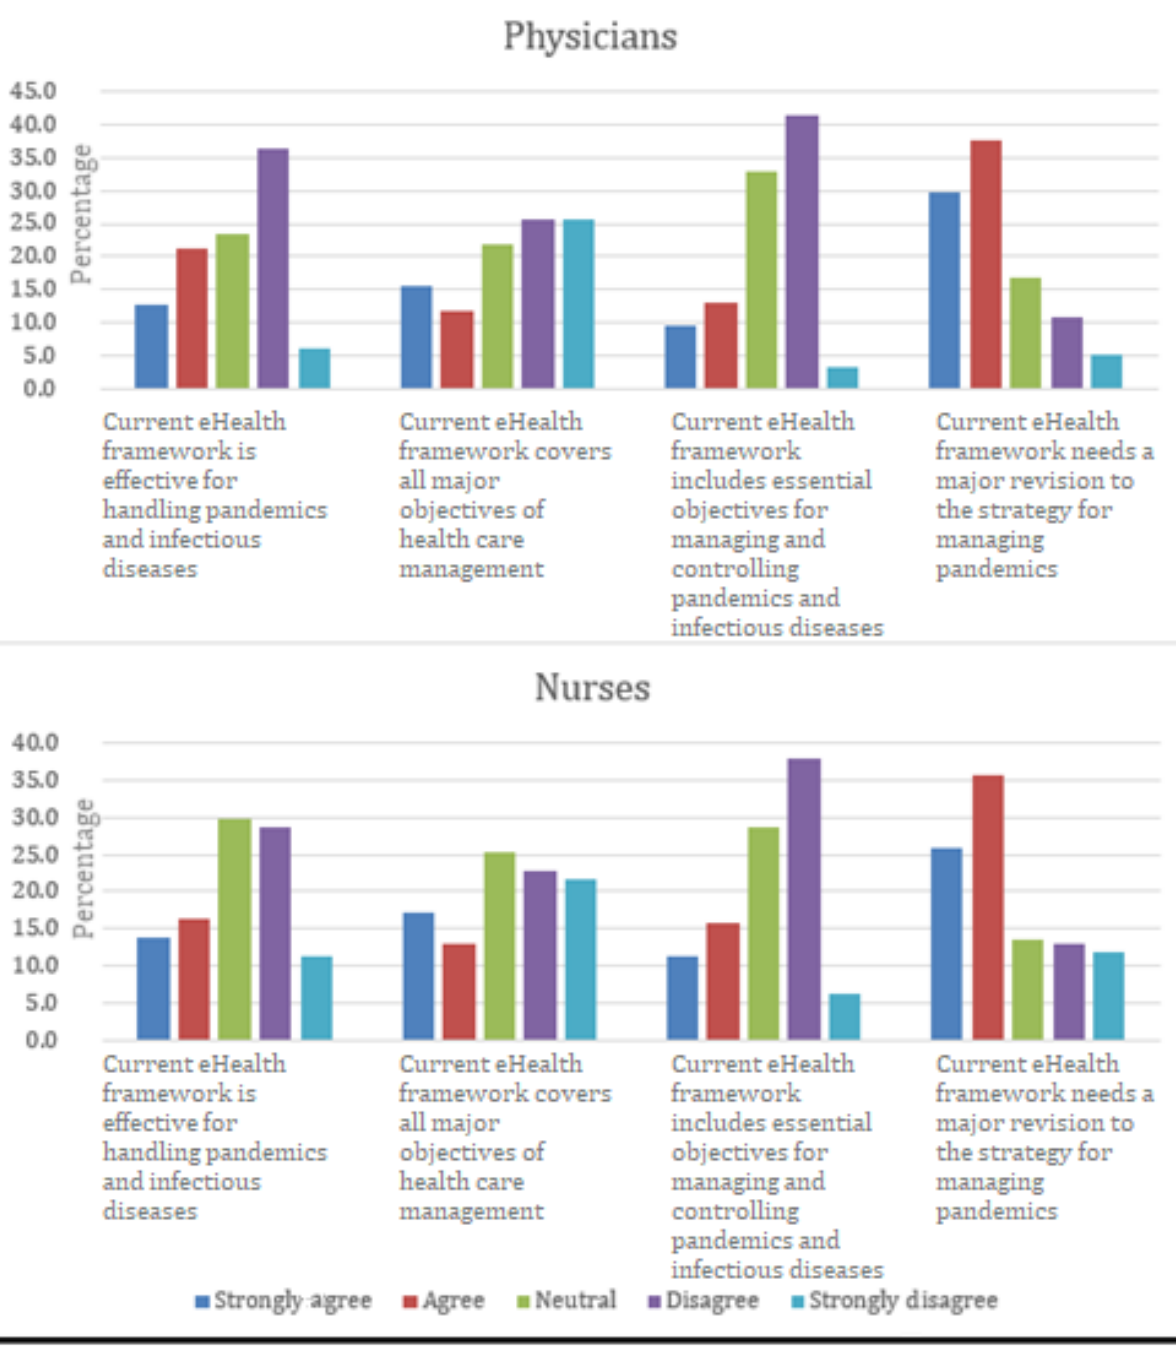
Figure 3. Comparison of the opinions of physicians and nurses regarding the current eHealth framework in Saudi